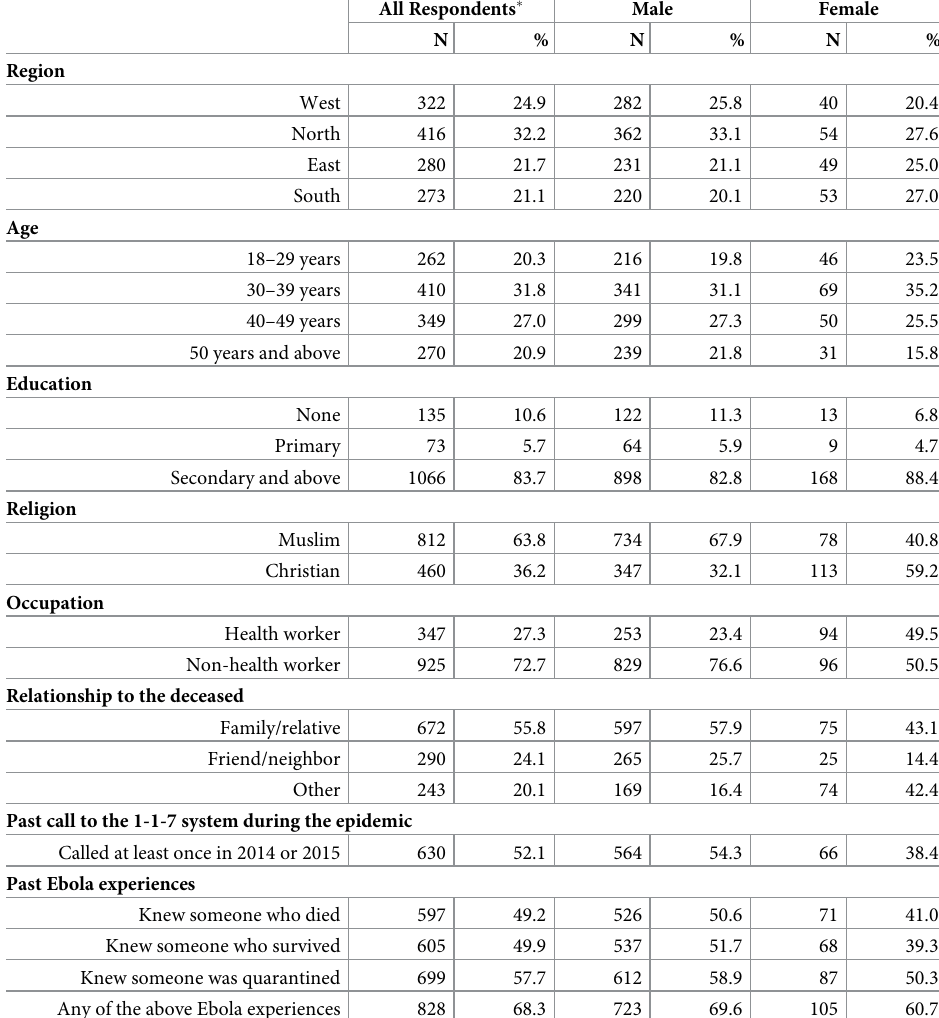
Table 1. Descriptions of respondents by sex, Sierra Leone, April